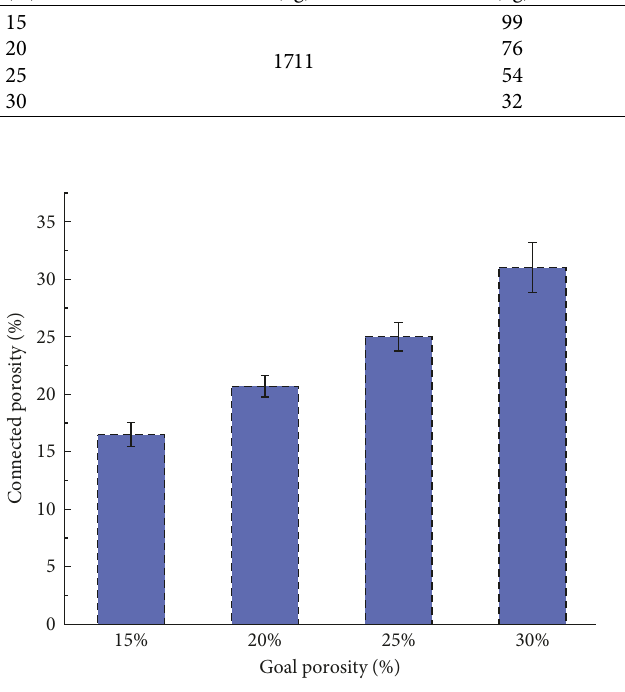
Figure 6: Test results of 150mm